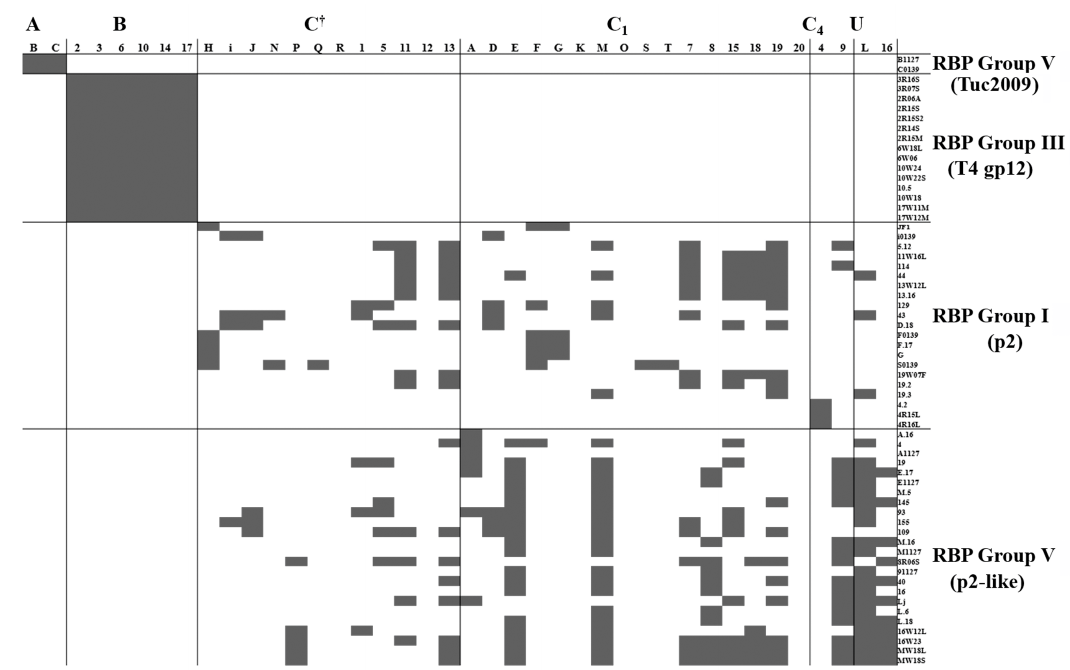
Figure 3. Host ranges of various phages isolated from whey samples between 2009 and 2015 [9,16,20]. Phages are divided by their RBP Group (groups on the right), and host strains by their CWPS Type (types across the top of the table; † denotes C type strains of undetermined subtype, U represents strains of an undetermined CWPS).